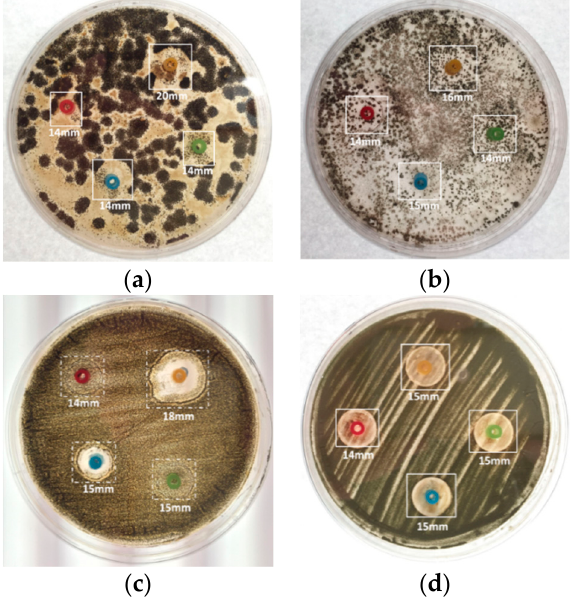
Figure 11. Pictures of inhibition zone test: ( a ) bathroom sample; ( b ) Penicillium; ( c ) Aspergillus Niger; ( d ) Aspergillus Flavus.